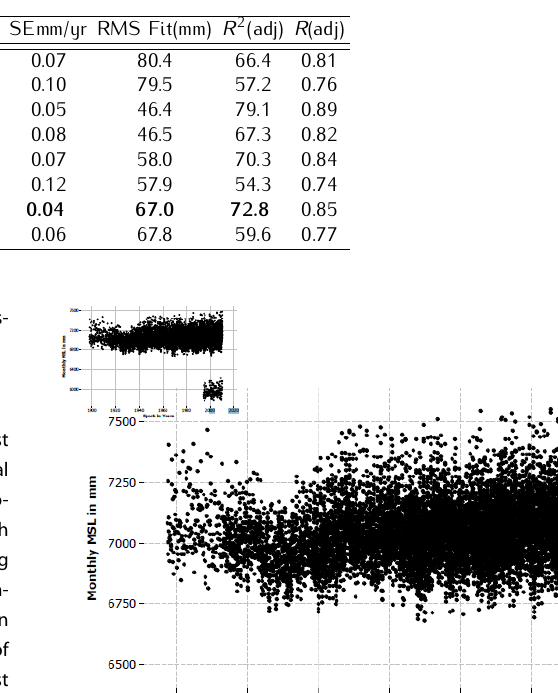
Table 4. The trend estimates from the three longest local tide gauge series and their combined solution (regional) trend are listed. The first row of each solution are the ordinary least squares estimates followed by their standard errors (SE). The second row statistics are from the generalized least squares solution that accounts for the autocorrelation. The generalized least square solution for the combined data also includes spatial correlation among three strations. All the other parameters not listed in the table (coefficients of the periodic variations) are in agreement within few mm.